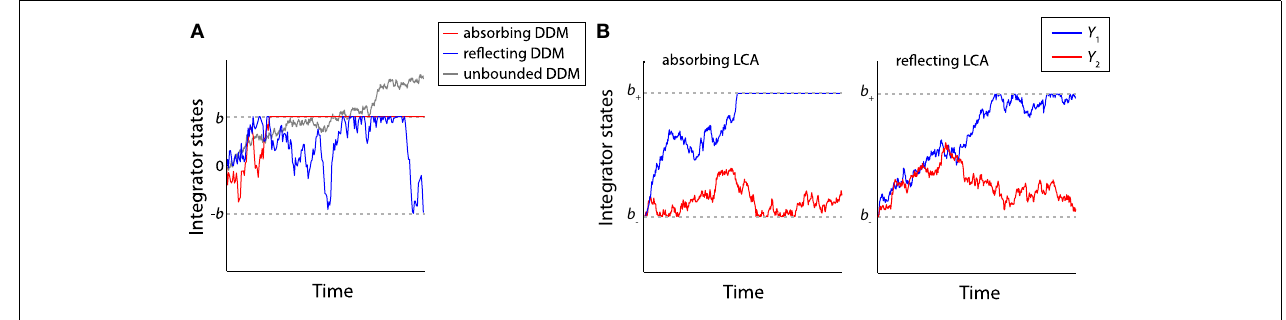
by the gray dashed lines. (B) Examples of trajectories of the absorbing (left panel) and reflecting (right panel) LCA models.The lower boundary ( b − ) and the upper boundary ( b + ) boundaries are indicated